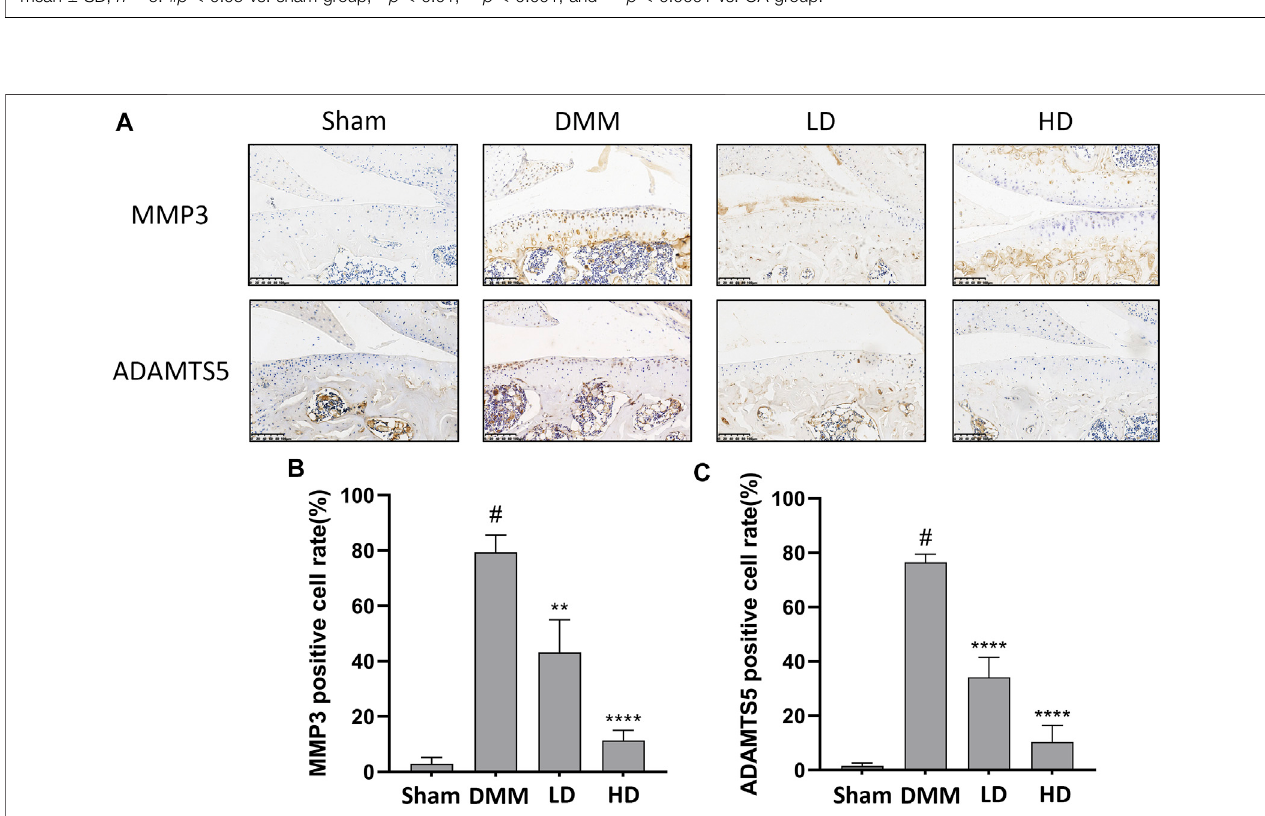
FIGURE 7 | CEP ameliorated cartilage in fl ammation in vivo . Immunohistochemistry (A) and quantitative analysis (B,C) for antibody against MMP3 and ADAMTS5. Scale bar = 100 μ m. LD and HD represent the dose of 5 and 15 mg/kg CEP, respectively. Values are expressed as mean ± SD, n = 6. # p < 0.05 vs. sham group, ** p < 0.01, and **** p < 0.0001 vs. OA group.